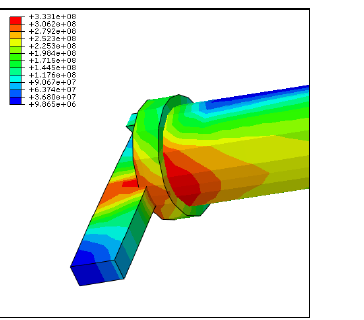
Table 2. Finite element analysis of the eccentric tension on the sockets on the horizontal bar. Tensile Capacity/kN